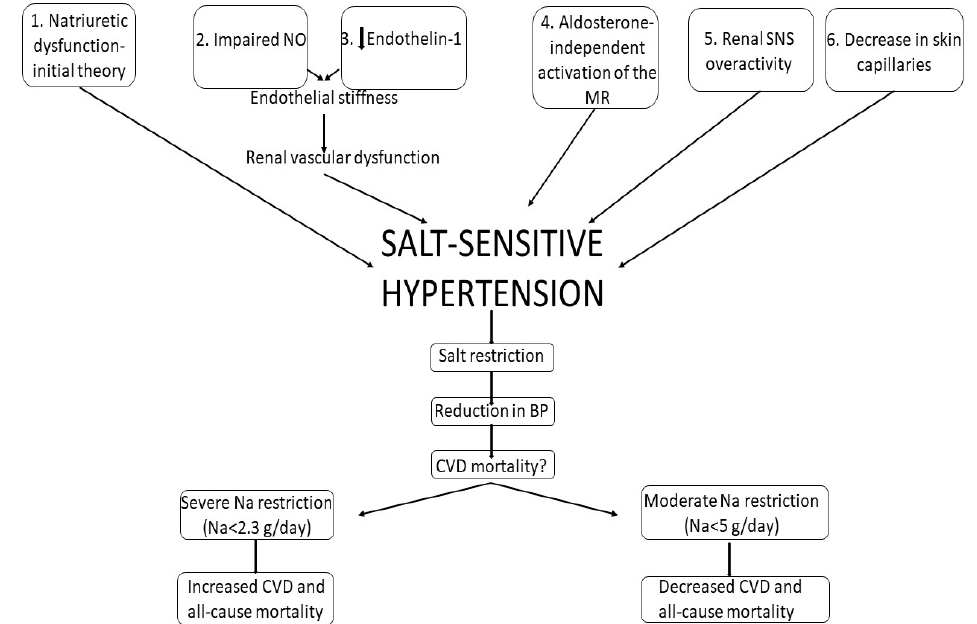
Figure 1. Development of salt-sensitive hypertension and various consequences of salt restriction. BP = blood pressure, CVD = cardiovascular disease, MR = mineralocorticoid receptor, Na = sodium, NO = nitric oxide, SNS = sympathetic nervous system.